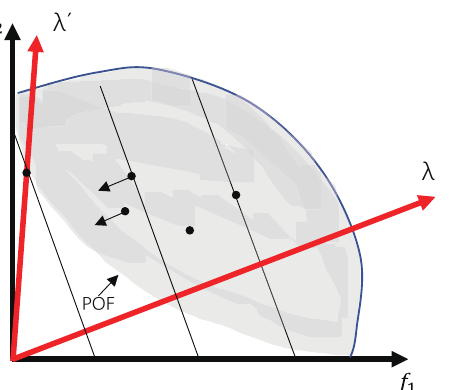
Figure 2. The contour of weighted sum approach. Concerning convex problems, several isometries can be drawn to discover the shortest distance points that together produce a different set of Pareto optimal vectors. For non-convex problems, the vertical line of each reference vector cannot be tangent to its leading edge. This figure is adopted from